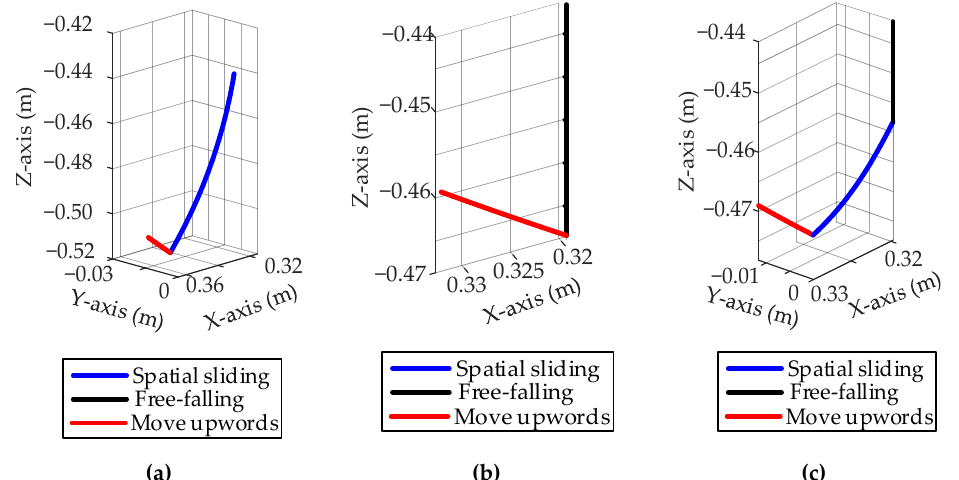
Figure 9. The path of particle in a single crushing cycle. ( a )The path of spatial sliding particle. ( b )The path of free-falling particle. ( c )The path of spatial compound falling particle. path of free-falling particle. ( c ) The path of spatial compound falling particle.